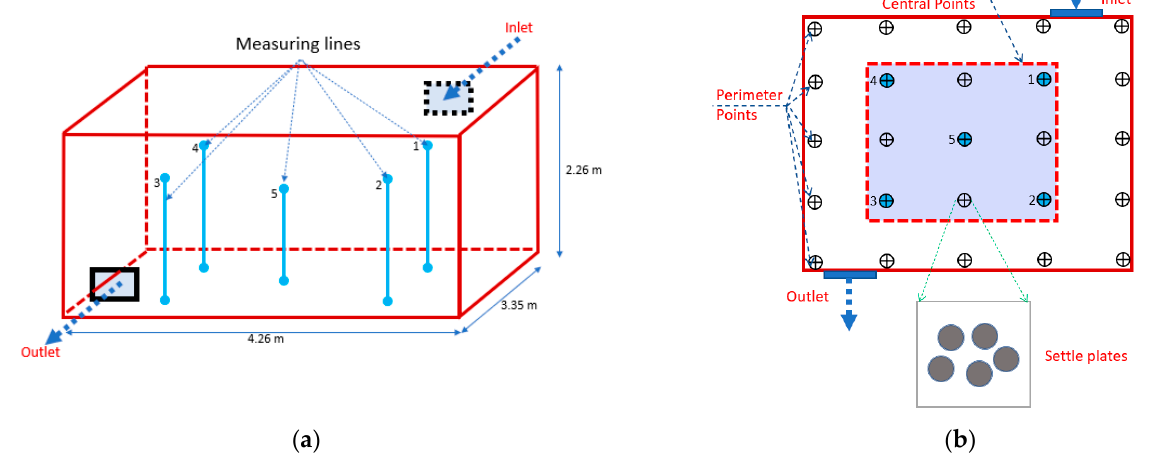
Figure 2. Locations of velocity measuring poles and settle plates (second validation experiment). ( a ) Locations of velocity measuring poles. ( b ) Locations of settle plates on the floor (plan view).